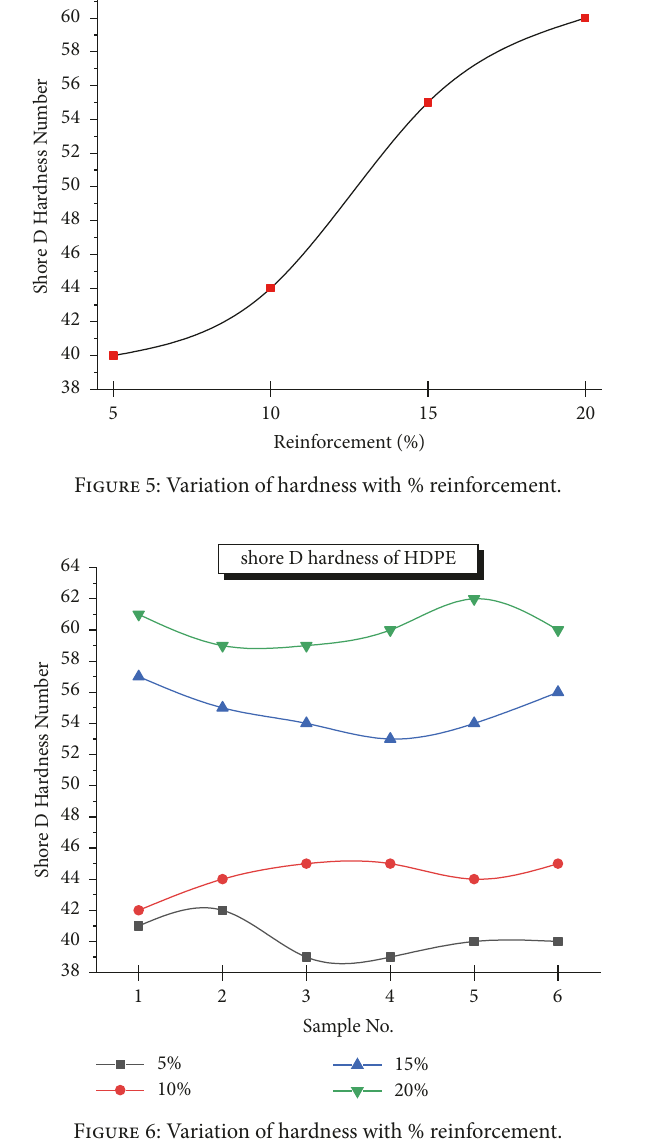
Figure 6: Variation of hardness with % reinforcement.